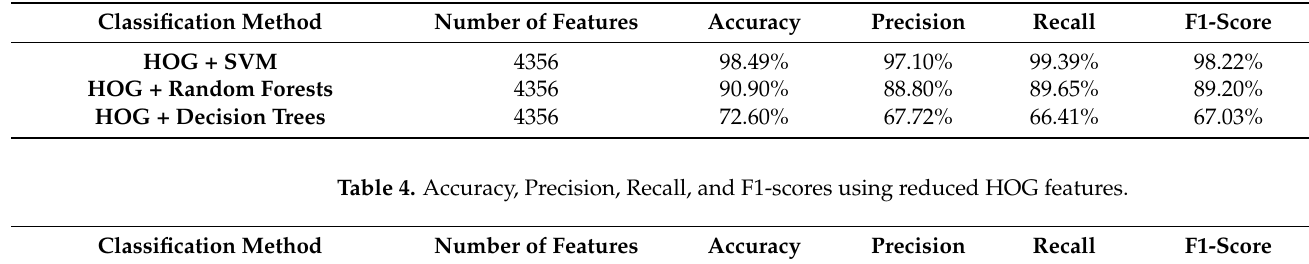
Table 3. Accuracy, Precision, Recall, and F1-scores using HOG features.